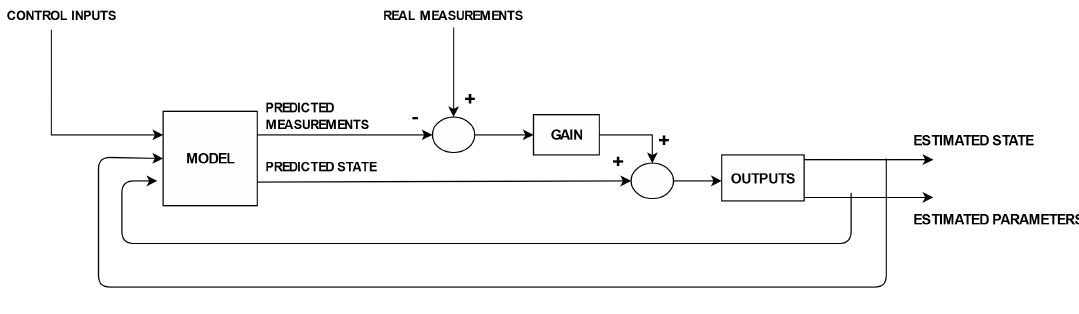
Figure 12. Block schema of the Kalman filter (KF)